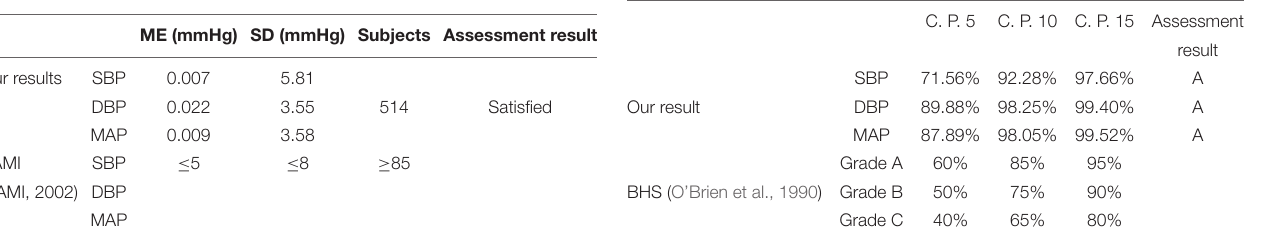
TABLE 2 | Comparison of estimated BP values between our work and AAMI standard.